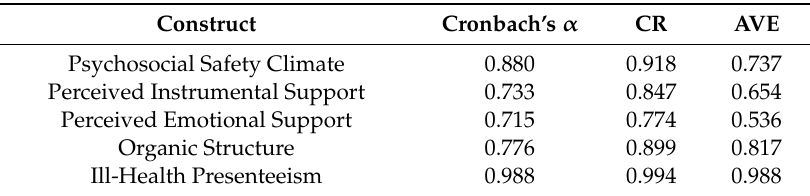
Table 1. Reliability test results for each